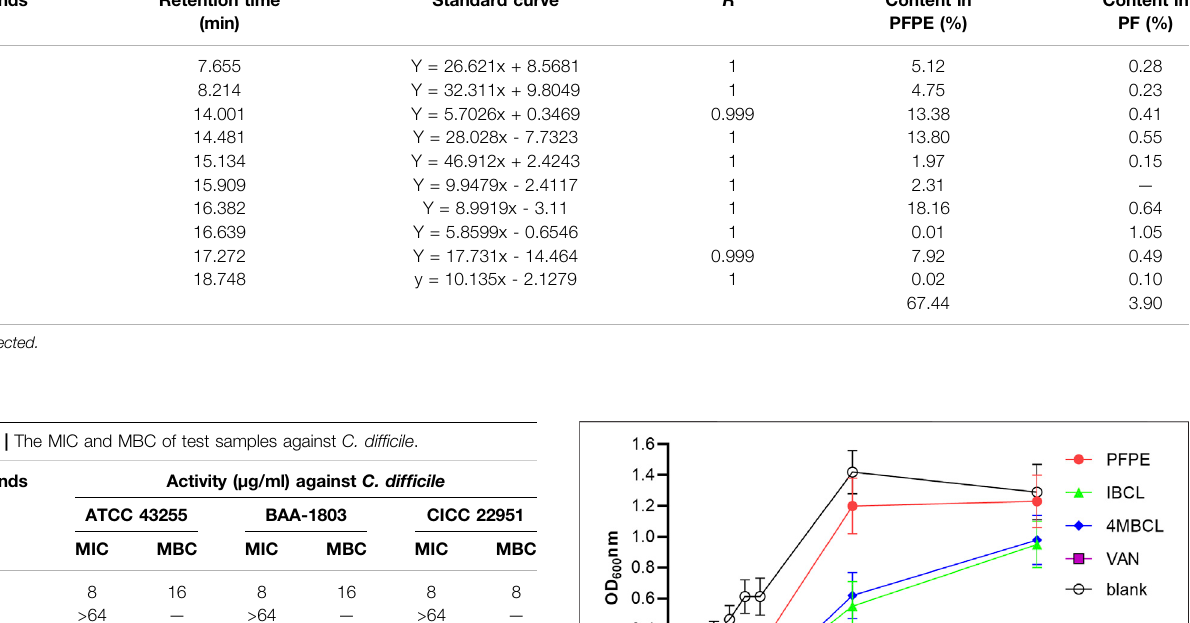
TABLE 1 | Parameters for the quantitative analysis of the major components in PFPE and PF. Compounds